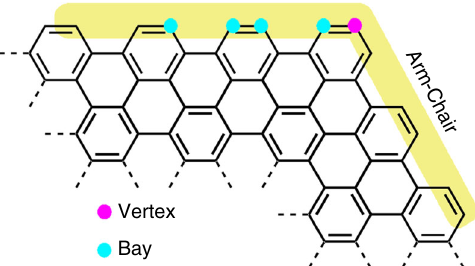
Fig. 1 Arm-chair edge of graphenic structures. Arm-chair edge contains two kinds of carbon sites, one at the bay (cyan point) and another at the vertex (magenta